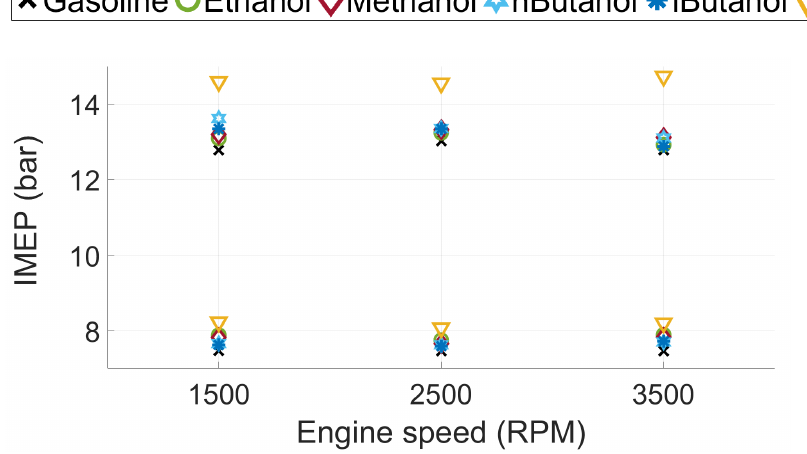
Figure 2. The engine test points marked for all tested fuels in terms of load (IMEP) and engine speed (RPM). All fuels were tested at two different load conditions and three different engine speeds for each load